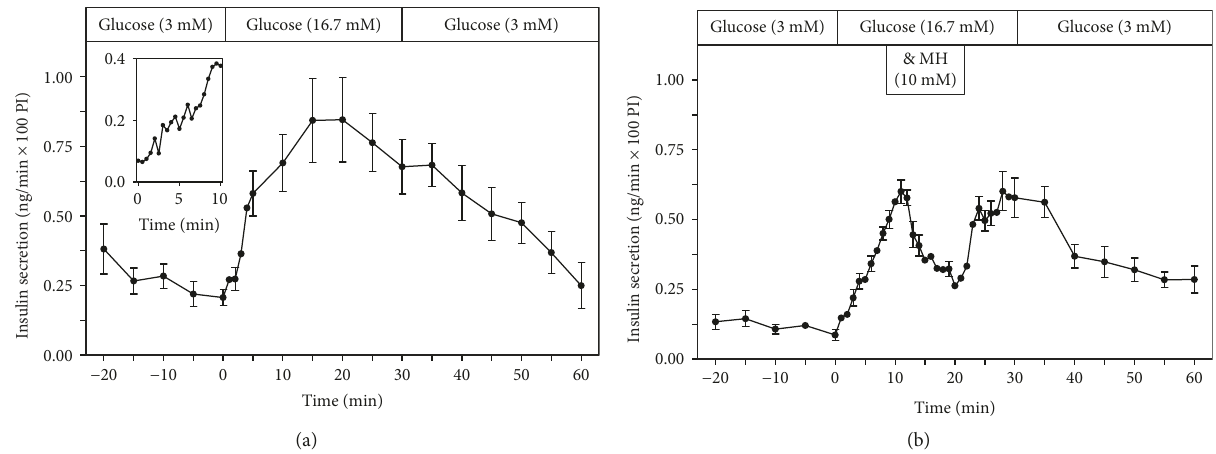
Figure 1: Kinetic pro fi les of insulin secretion from perifused EndoC- β H1 β -cell pseudoislets in response to a 30 min stimulation with glucose (16.7 mM) (a) ( n = 7 ) and to the inhibition of glucose-induced (16.7 mM) insulin secretion by mannoheptulose (10 mM) (11 – 20min) (b) ( n = 4 ). After a 20min preperifusion phase with basal glucose (3 mM), a 30min stimulation period with high glucose (16.7 mM) and thereafter a return of the perifusion to basal glucose medium (3 mM) again for another 30min are depicted. The inset in (a) shows a magni fi cation of the initial 10 min glucose (16.7mM) stimulation period of the perifusion. Shown are means ± SEM of insulin release rates expressed as ng/min and per 100 pseudoislets